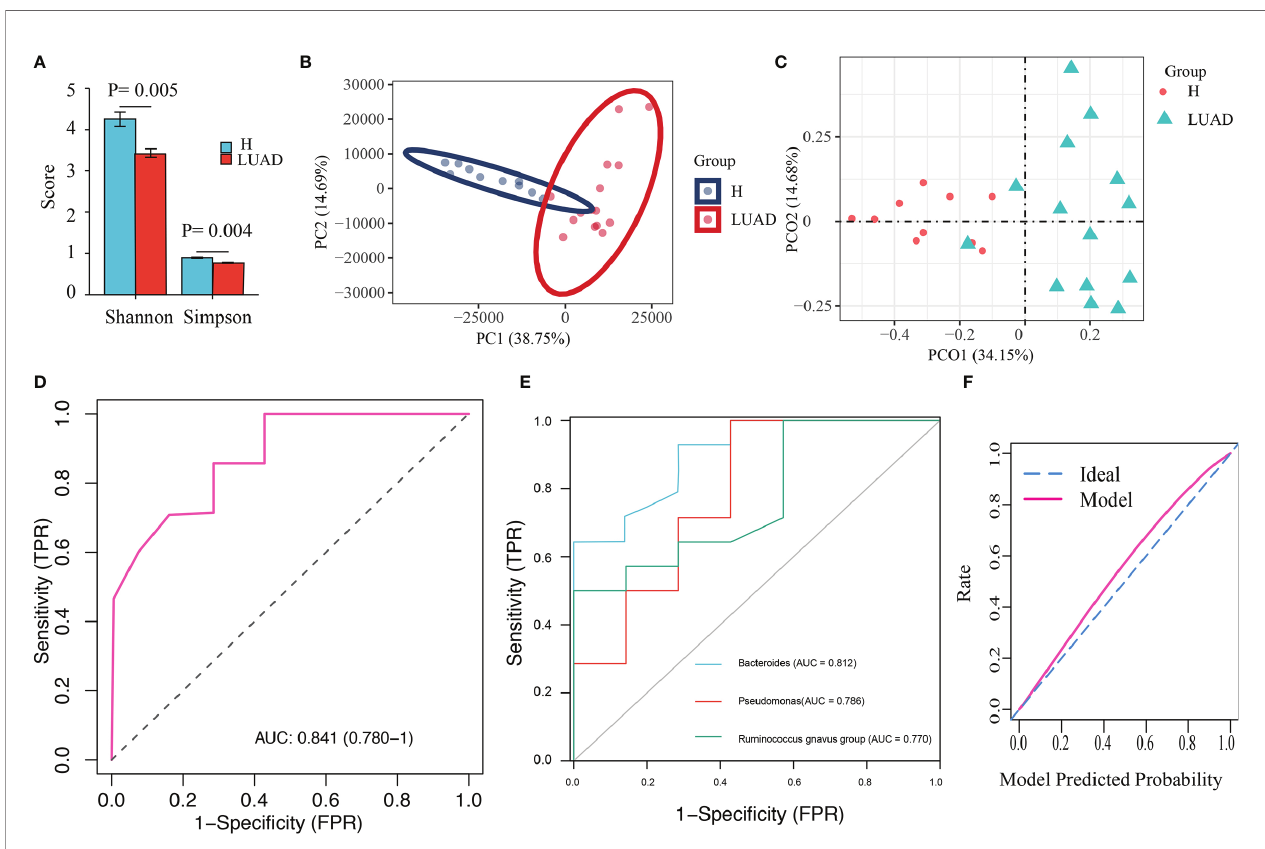
FIGURE 5 | Validation of the diagnostic model with Metagenomics. (A) The a diversity is evaluated by Shannon and Simpson index. (B) The b diversity was evaluated by PCA analysis. (C) The b diversity was evaluated by PCoA analysis. (D) The ROC of the diagnostic model. (E) The ROC of three biomarker ’ s taxa. (F) The calibration plot of the diagnostic